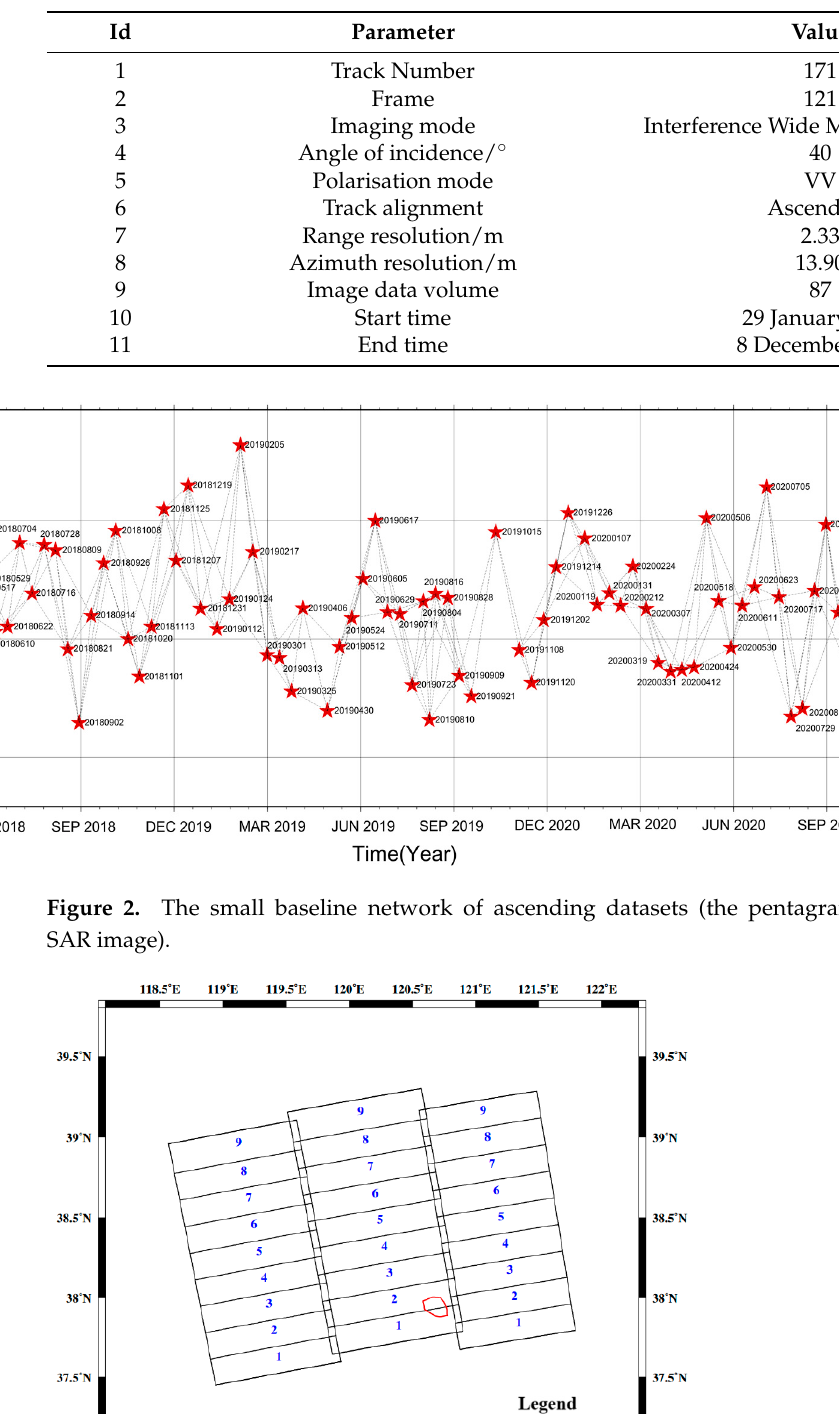
Table 1. Sentinel-1A data parameters.